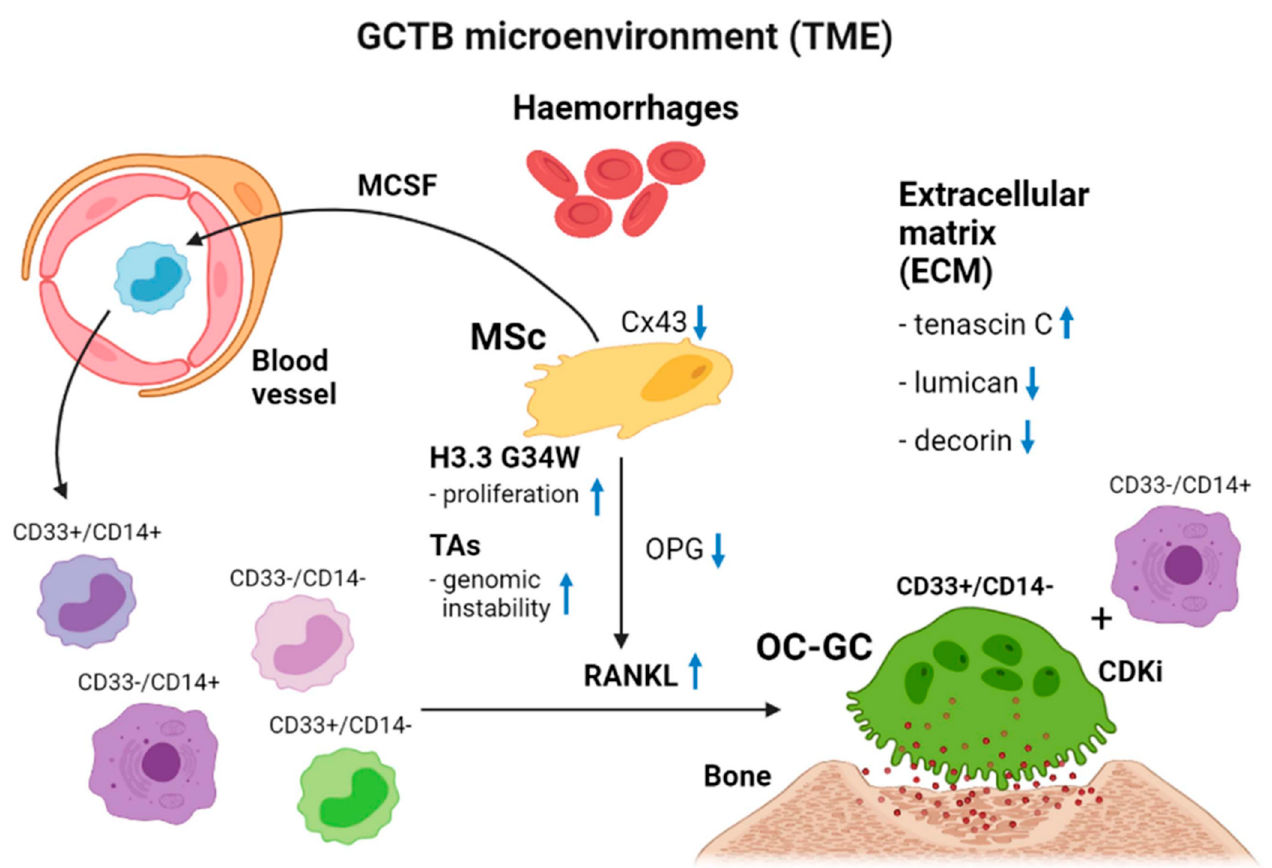
Figure 2. Schematic representation of the tumour microenvironment of GCTB. MCSF, macrophage colony stimulating factor; MSc, mononuclear spindle cell; TAs, telomeric associations; TME, tumour microenvironment; ECM, extracellular matrix; OPG, osteoprotegrin; OC-CG, osteoclastic giant cell. The interference of the four different components of GCTB makes the biological behaviour of GCTB unpredictable. The mononuclear spindle-shaped cell as first component harbours an H3.3 driver mutation affecting several internal and external cell biological processes. By secretion of MSCF, blood-borne monocytes are attracted to the tumour microenvironment. Under the influence of extensive RANKL in combination with a lower OPG secretion by the neoplastic cell, high numbers of large osteoclastic giant cells (second component) are formed by fusion of CD33 + /CD14 − , CD33 + /CD14 + and CD33 − /CD14 + macrophages. These osteoclastic giant cells are responsible for the osteolytic properties of GCTB. Macrophages not committed to osteoclastogenesis are regarded as tumour-associated macrophages (third component). The extracellular matrix (fourth component) facilitates the mobility of cells in the matrix by expressing tenascin and underexpressing decorin and lumican. The presence of haemorrhages is mostly seen in primary tumours that behave more aggressively or that give rise to benign metastatic lung plugs. Finally, a circulus vitiosus of osteolytic expansion has been created by the tumour itself.